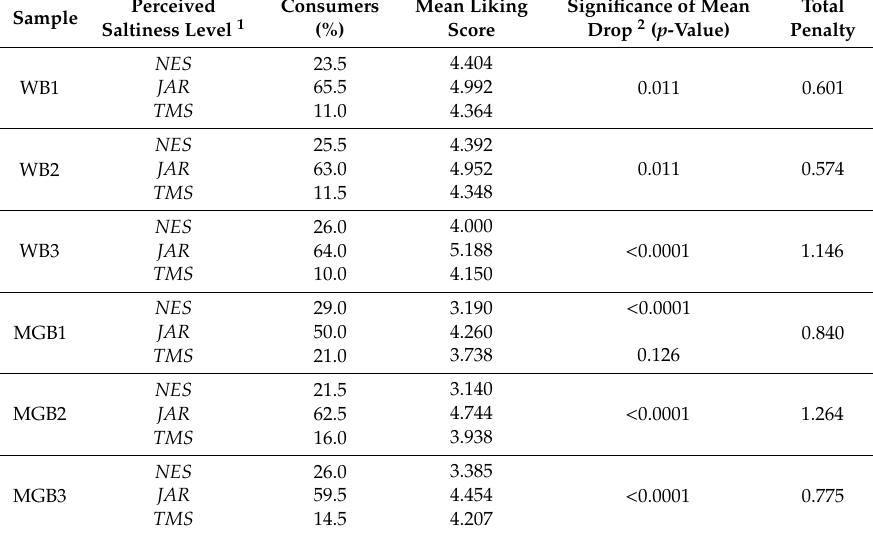
Table 3. Penalty analysis table with mean overall liking scores (7-point hedonic scale) by JAR